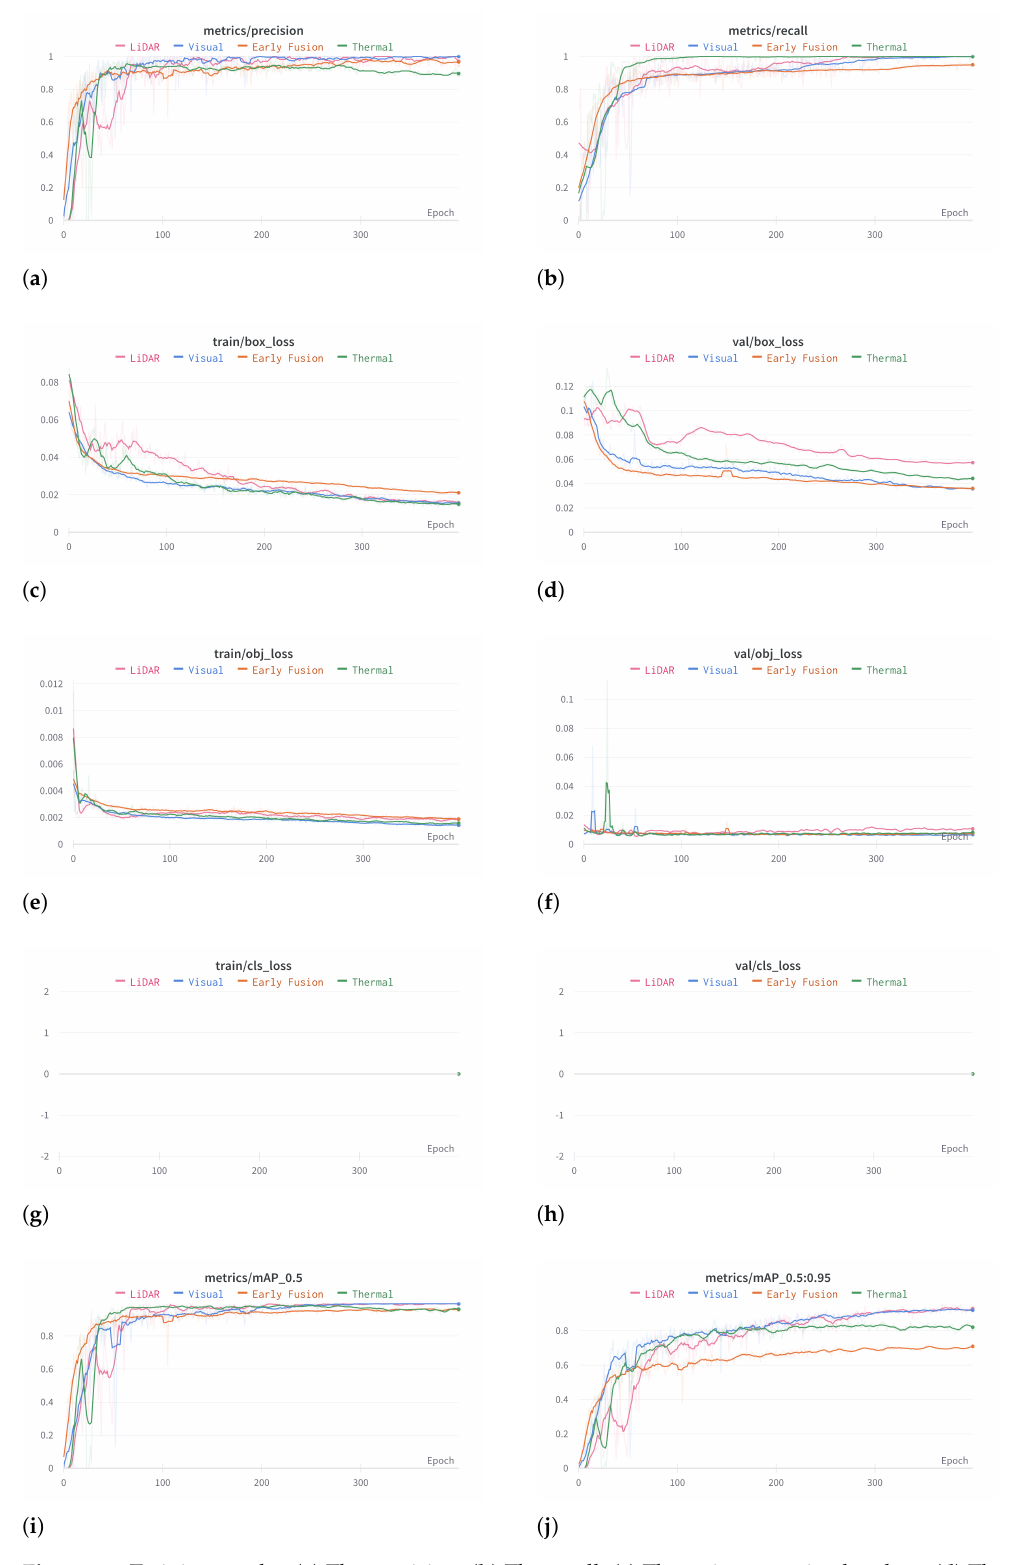
Figure 12. Training results. ( a ) The precision. ( b ) The recall. ( c ) The train regression box loss. ( d ) The validation regression box loss. ( e ) The train regression object loss. ( f ) The validation regression object loss. ( g ) The train regression class loss. ( h ) The validation regression class loss. ( i ) The Mean Average Precision 0.5 accuracy. ( j ) The Mean Average Precision 0.5:0.95